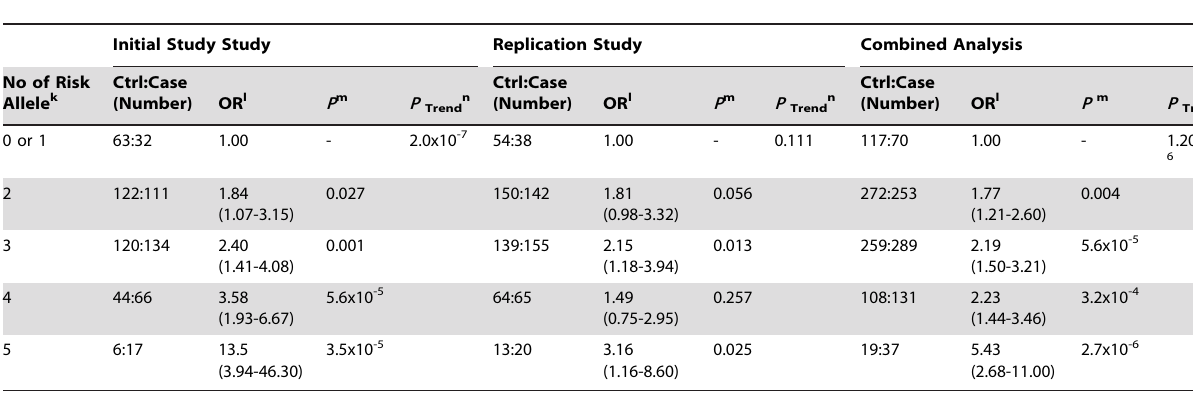
Table 4 . Cumulative Effect of Risk Alleles on Ischemic Stroke